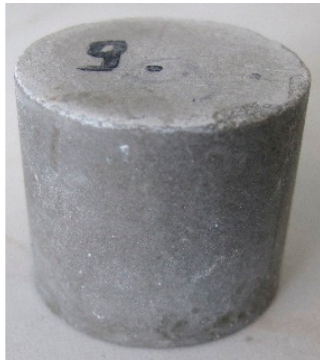
Figure 7. A sample of hardened cement slurry for gas permeability testing.